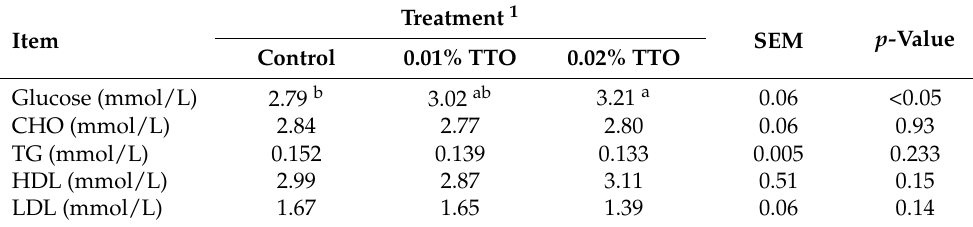
Table 5. Effects of TTO on serum glucose and lipid metabolism in postpartum dairy